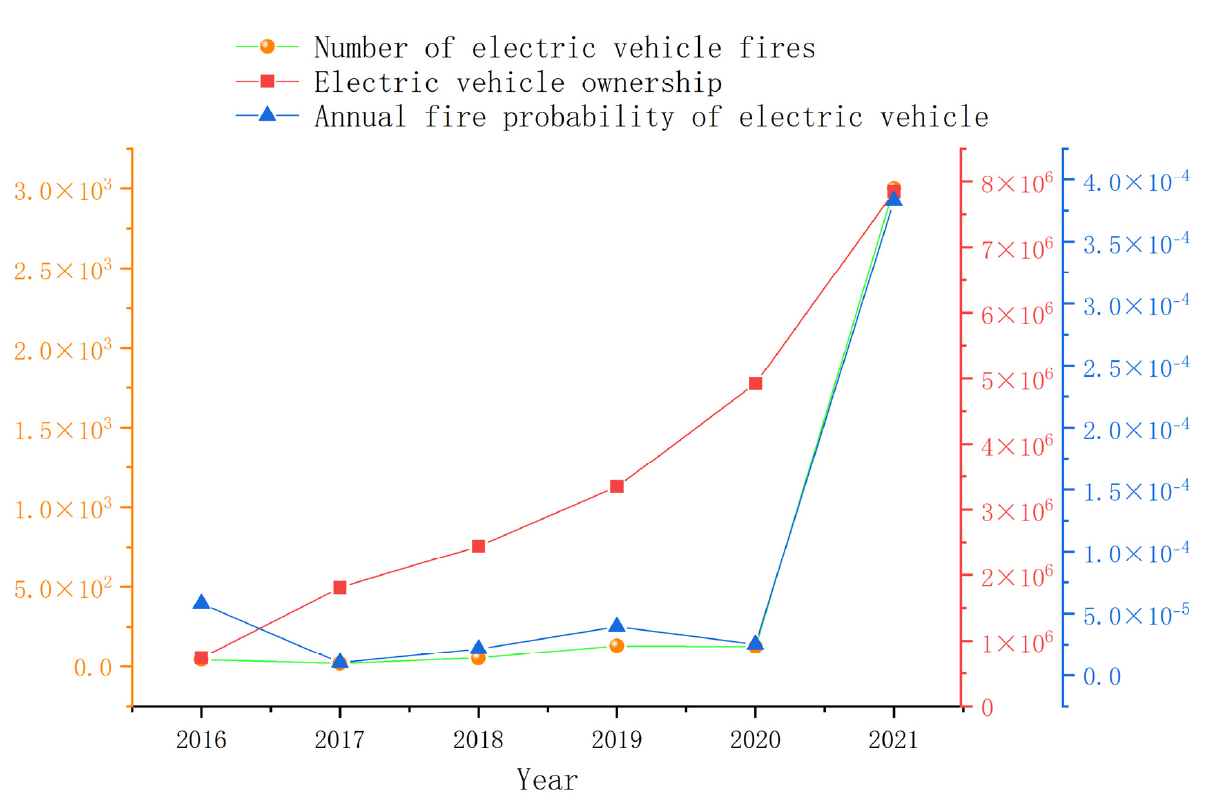
Figure 10. Change trend of electric vehicle retention, electric vehicle fire number, and fire probability from 2016 to 2021.